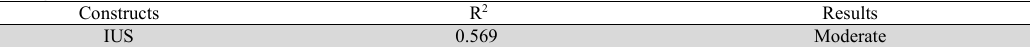
Results of path tests